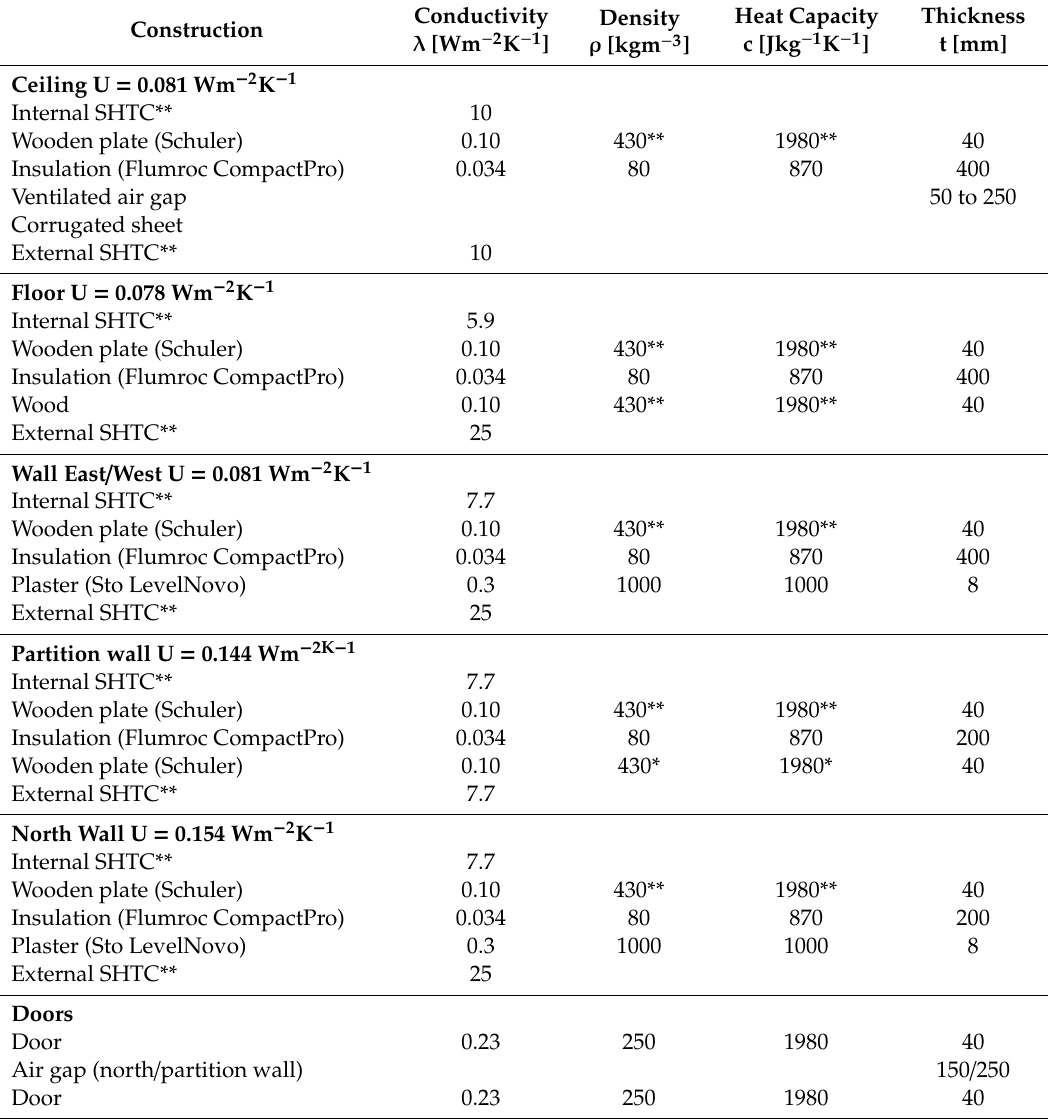
Table 1. Material properties of building materials for the test